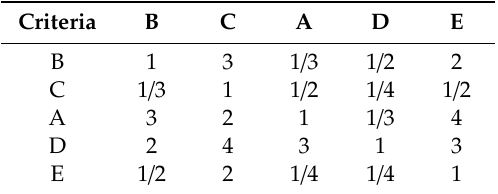
Table 9. Matrix of comparing pairs between main criteria by real numbers.